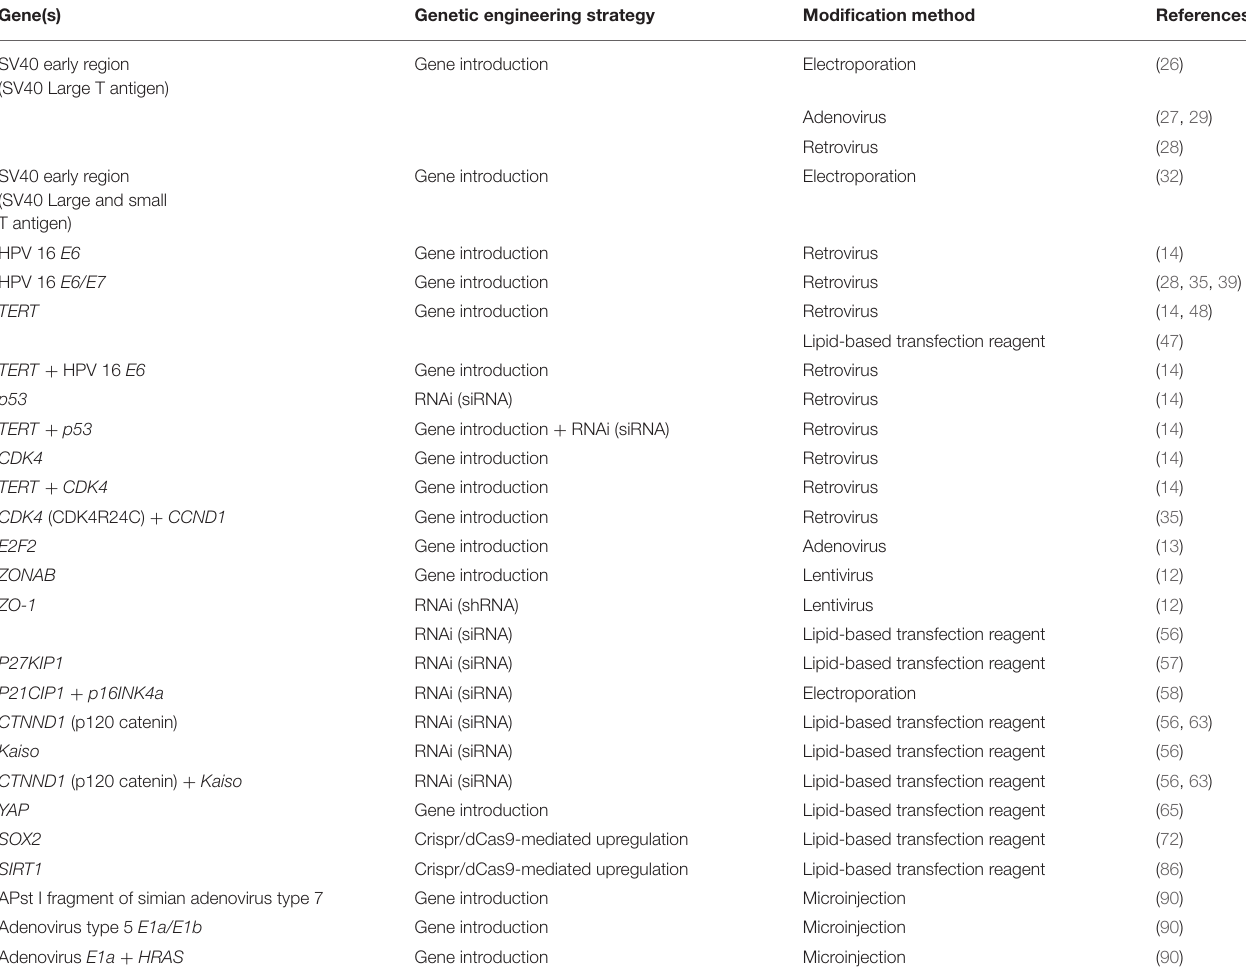
TABLE 1 | Genes of which the expression has been modified to increase proliferation in HCEnCs. For each gene of which the expression was altered in HCEnCs to enhance cell proliferation, the strategy that was used for genetic engineering and the method of modification is shown.